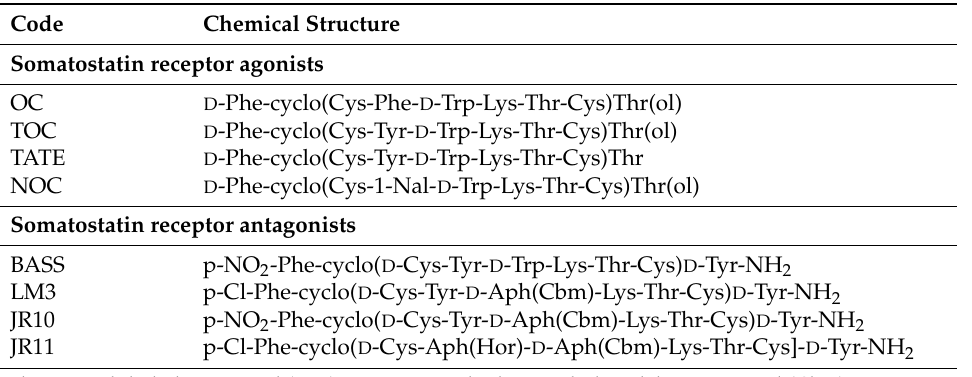
Table 1. Amino acid sequence of the somatostatin analogs discussed in the review. Code Chemical